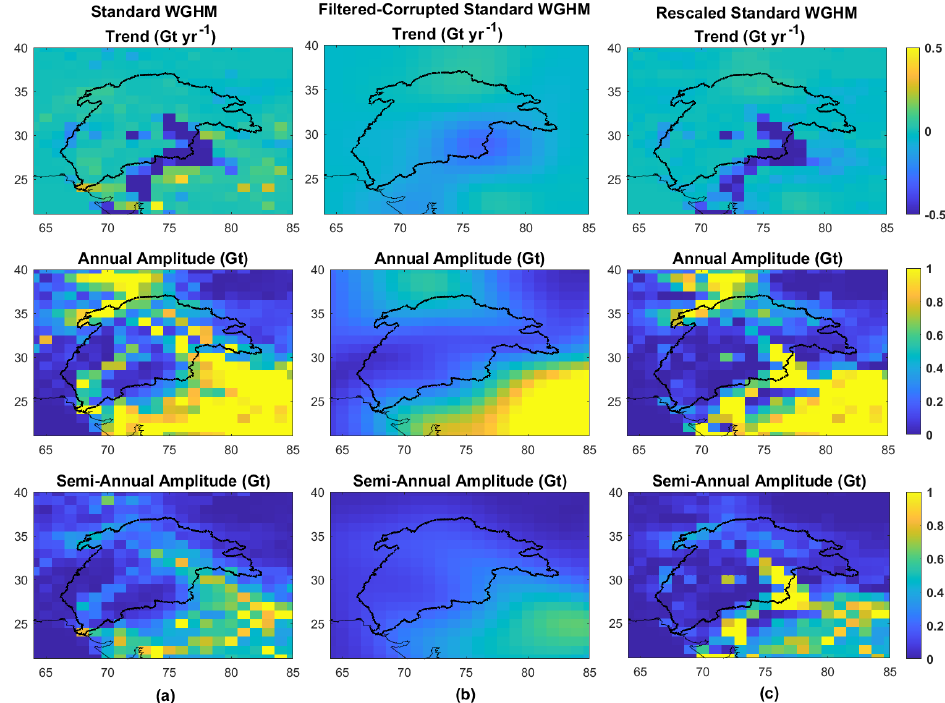
Figure 17. True (a) and recovered (c) spatial patterns of different mass change components from grid scaling of filtered–corrupted standard WGHM fields (b) in the simulation experiment.